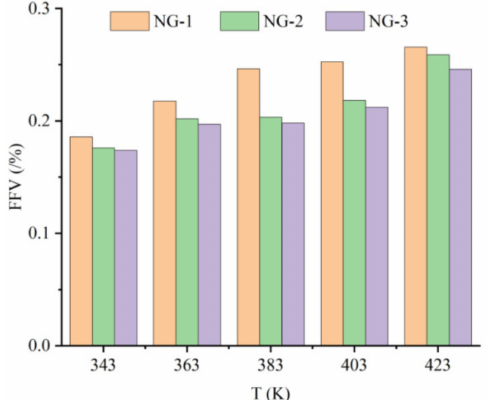
Figure 8. Free volume fraction of three models at different